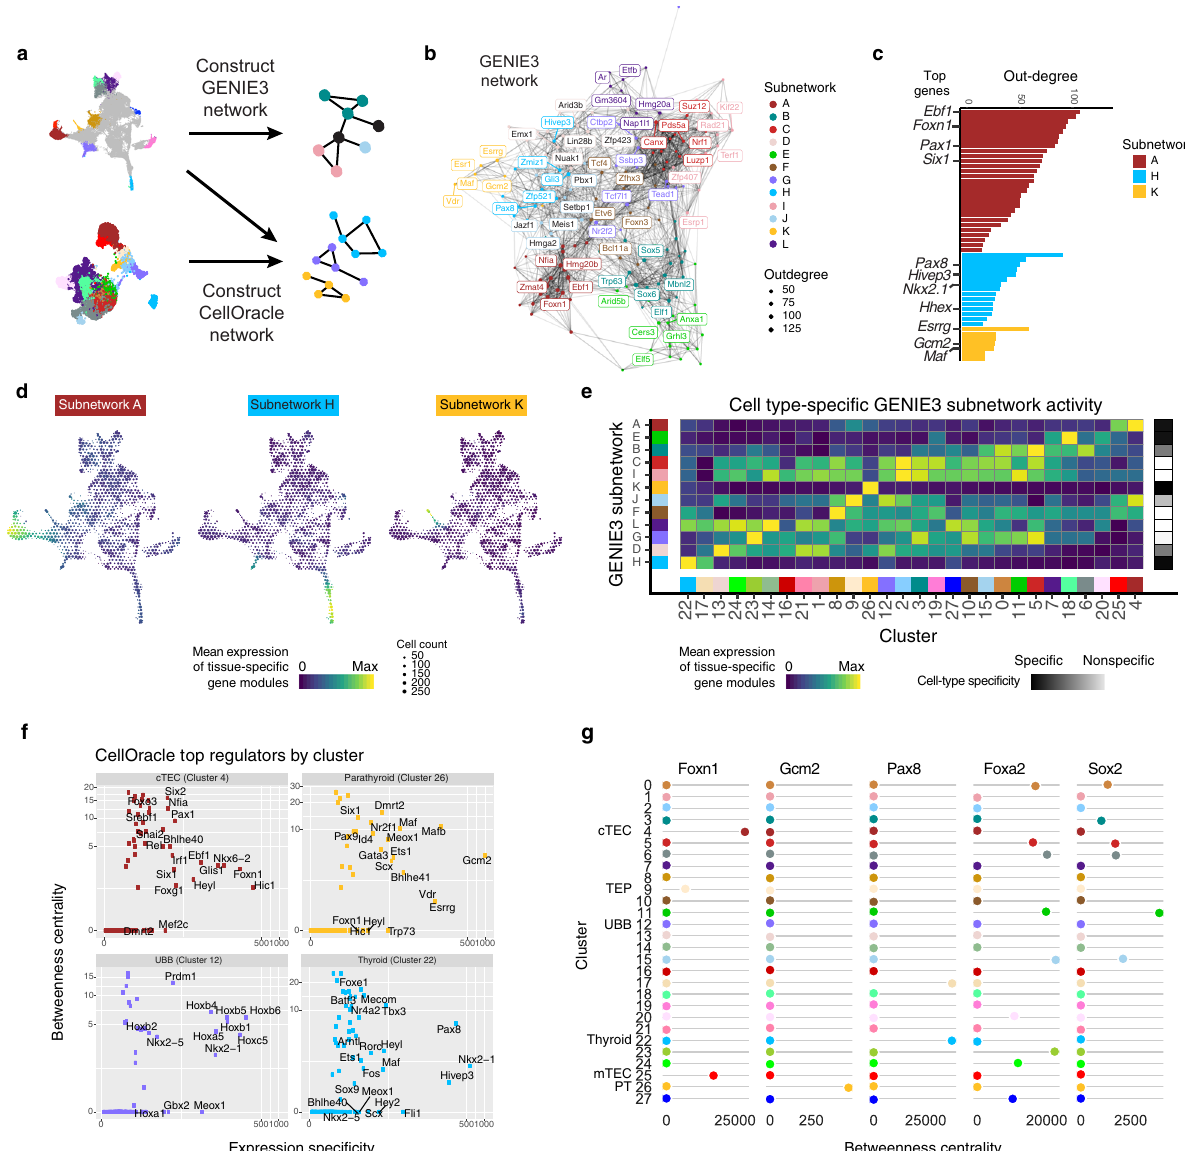
Fig. 4 Gene regulatory networks reveal cell-type-speci fi c regulatory interactions. a Gene regulatory network (GRN) schematic for our two complementary approaches, GENIE3 and CellOracle. b GENIE3 GRN showing the top 200 regulators clustered into subnetworks. Regulators were fi ltered according to predicted regulation of the top differentially expressed genes across the entire dataset. The top 5 regulators of each subnetwork are labeled. c Regulators ranked by outdegree for three GENIE3 subnetworks: A, H, and K. d UMAP embeddings of the mean scRNA expression of subnetwork speci fi c genes showing three highly cell-type-speci fi c subnetworks. Subnetworks A, H, and K correspond to the thymus, thyroid, and parathyroid, respectively. Cells are binned by UMAP coordinate with size proportional to the number of cells and color signifying average log2-normalized expression. e Heatmap showing the cell-type speci fi city of GENIE3 subnetworks using the mean subnetwork activity on the scRNA atlas clusters. f Bivariate plot of average betweenness centrality from the cluster-speci fi c CellOracle network and normalized expression speci fi city (average cluster-speci fi c expression/median average cluster- speci fi c expression) showing the top regulators per cluster. g Betweenness centrality network score dynamics as estimated by CellOracle across clusters for selected regulators of thymus ( Foxn1 ), parathyroid ( Gcm2 ), thyroid ( Pax8 ), anterior foregut ( Foxa2 and Sox2 ) development. cTEC cortical thymic epithelial cell, TEP thymic epithelial progenitor, UBB ultimobranchial body, mTEC medullary thymic epithelial cell, PT parathyroid. reduced cellularity in the Foxn1 heterozygous thymus 60 . Closer evaluation of the cell-type abundance by cluster showed that the Foxn1 KO is speci fi cally depleted for clusters 4 and 25, which comprise the thymus lineage (Fig. 5d). Differential gene expression analysis between the Foxn1 KO and control con fi rms all 5 differentially expressed transcripts previously identi fi ed by microarray pro fi ling of E12.5 nude thymus: Pdlim1 , Mfsd12 , Mreg , Fam57a , and Ppp1r16b 61 (Supplementary Dataset 6).